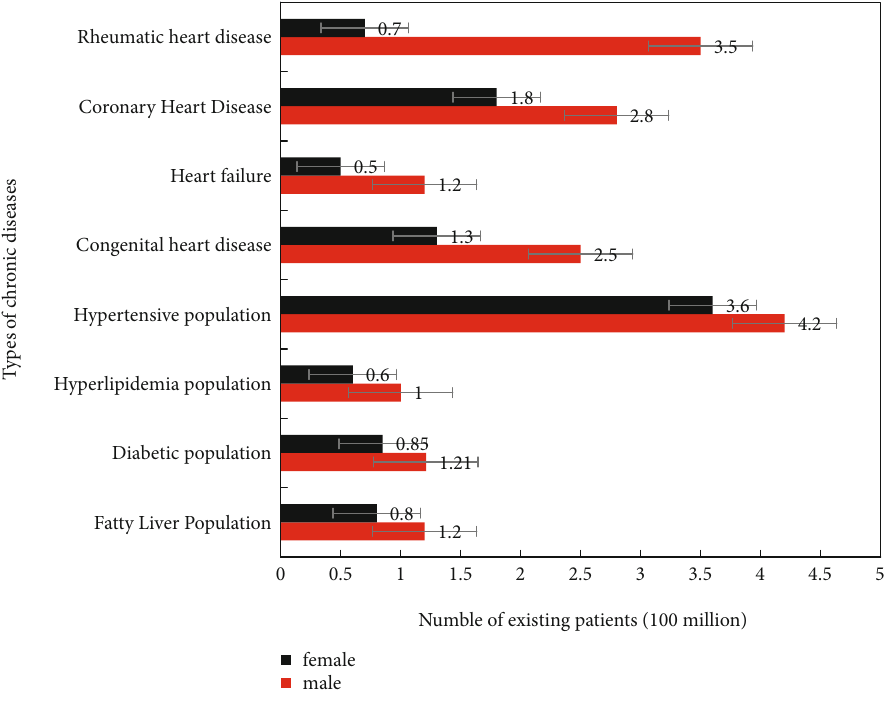
Figure 5: My country ’ s male and female data on chronic diseases. Table 2: Chronic disease management and nursing service standard program index